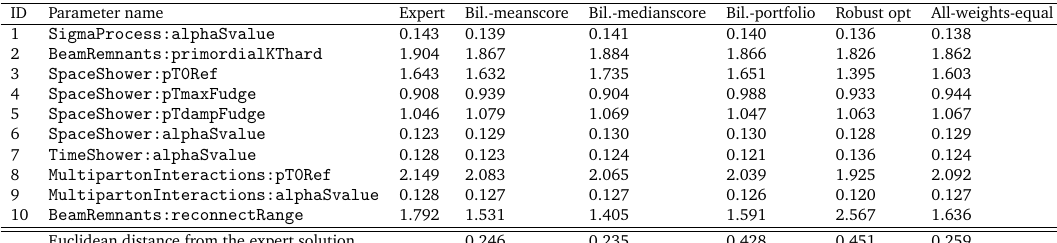
Table 23: Optimal parameter values for the A14 dataset obtained when using all observables in the optimization and the cubic polynomial approximation.